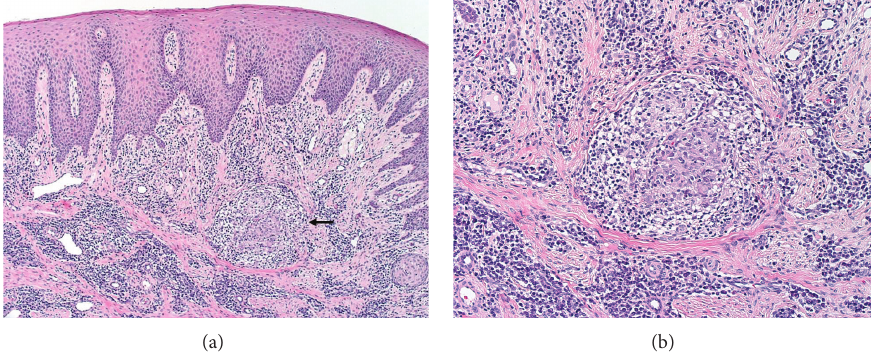
Figure4:Histopathologicimagesoftherightmandibulargingiva.(a)Low-powerviewshowingstratifiedsquamousepitheliumwithscattered intraepithelial lymphocytes (exocytosis). The underlying fibrous connective tissues are characterized by a patchy chronic inflammatory cell infiltrate and an isolated granuloma (arrow) (hematoxylin and eosin, 40x). (b) High-power view showing a well-defined, noncaseating granuloma composed predominantly of epithelioid histiocytes and lymphocytes (hematoxylin and eosin,